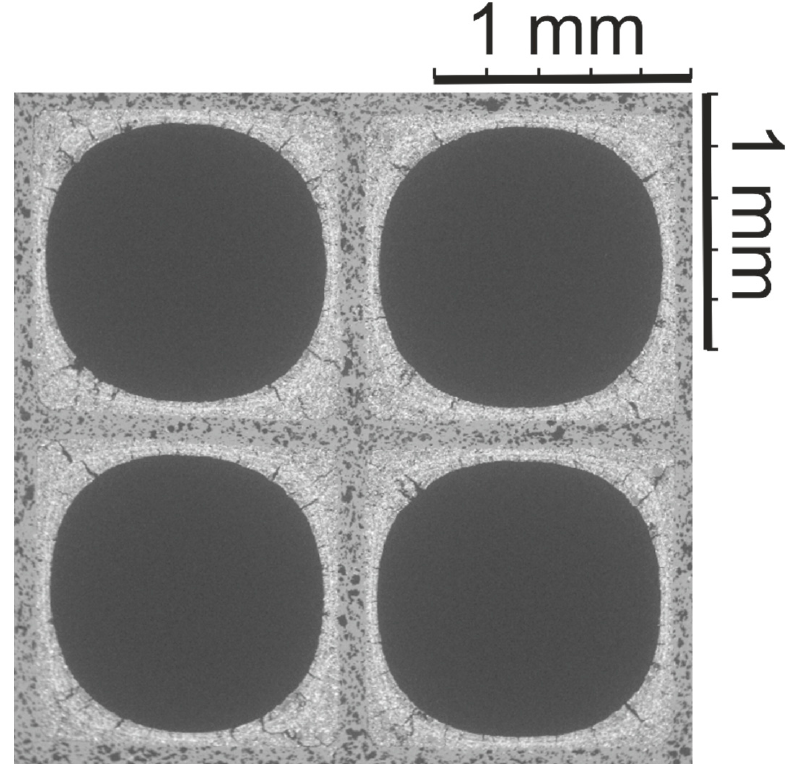
Figure 1. SEM image (×30) of the Pd/Rh catalyst.